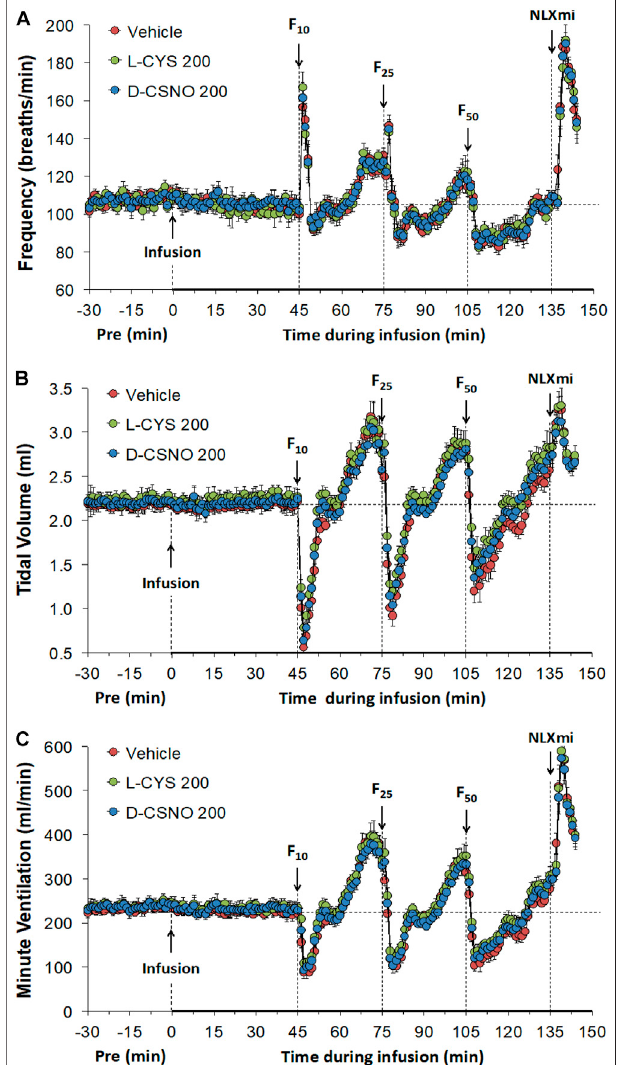
FIGURE 6 | Frequency of breathing (A) , tidal volume (B) and minute ventilation (C) values. The infusion of vehicle (20 μ l/min, IV),